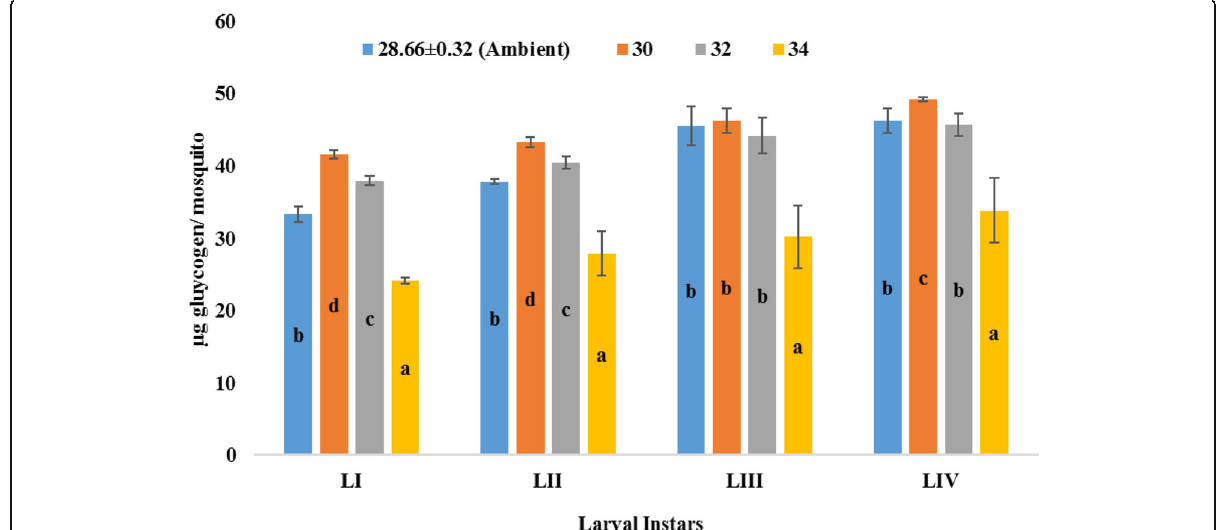
Fig. 6 Effects of rearing-water temperature on teneral glycogen accumulation across larval instars (LI – IV) of Culex quinquefasciatus mosquito. Temperature bars with same letter at each larval instar are not significantly different at p < 0.05 according to analysis of variance. Values are expressed as mean ± SD